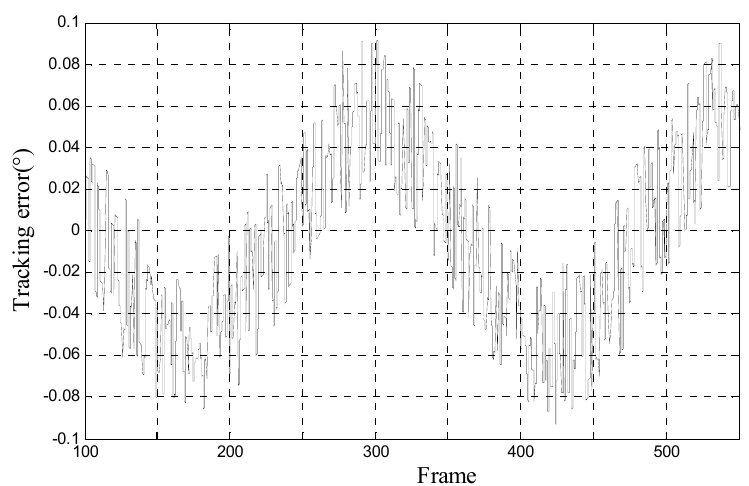
Figure 12. Tracking error of proposed method when moving-target move with 10° 0.2 Hz. (Note: Figures 10–12 are drawn by the miss-distance data in the opto-electronic platform with 50 frames per second).